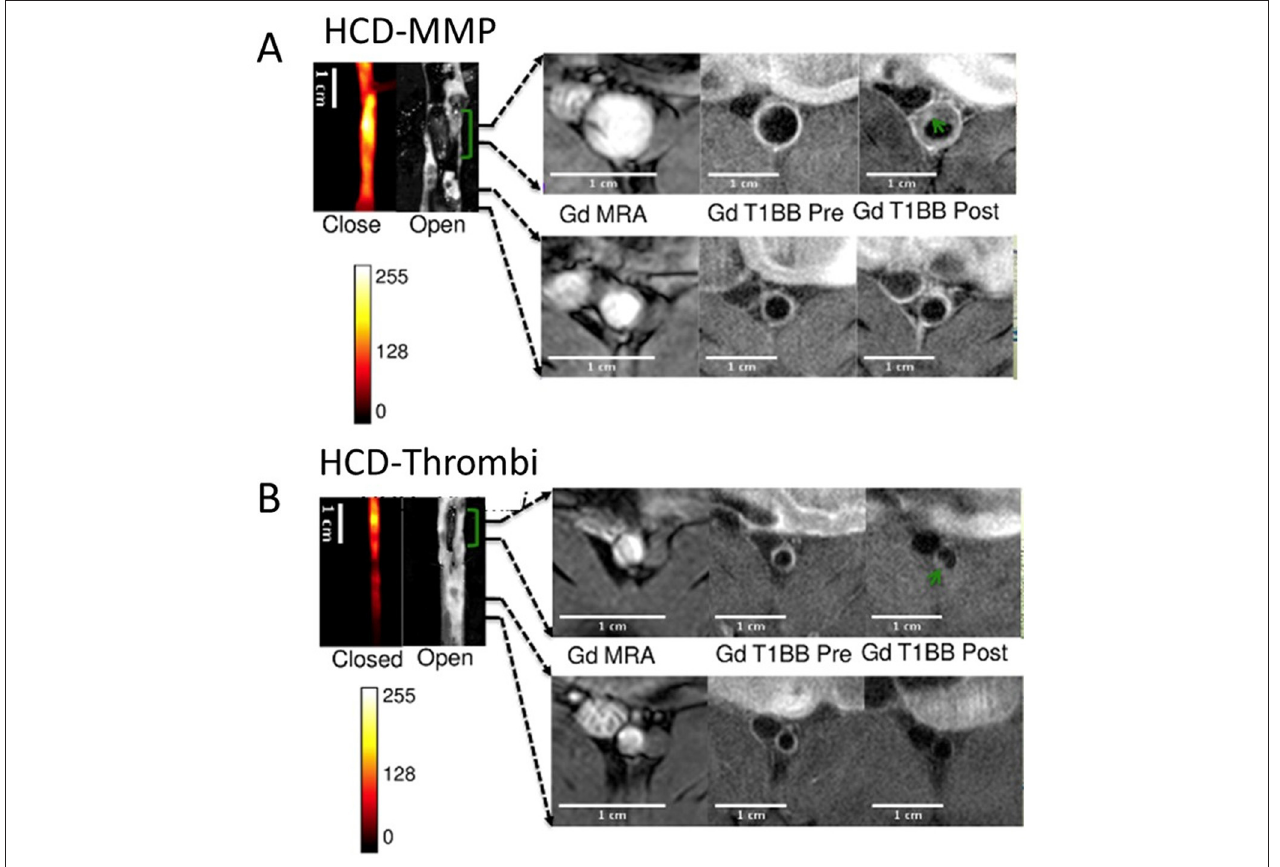
FIGURE 5 | Thrombus imaging. Fluorescence and MRI images of rabbits collected using a (A) HCD + MMP-ACPP probe and (B) HCD + Thrombin-ACPP probe, respectively. The closed view of the fluorescence images shows a sub-section of the abdominal aorta and the corresponding open view reflects images showing the location of thrombi (green brackets). The regions within the two black lines represent examples of non-disrupted and disrupted plaques, respectively, and correspond to the MRI images on the right. All MRI images were obtained after injection of Gd-DTPA according to acquisition protocols. Illustrated are the pre-triggering magnetic resonance angiography (MRA) and the fat suppressed T 1 BB images obtained before and after pharmacological triggering (from left to right). Thrombi are marked by green arrows in post-triggering Gd-T 1 BB (T 1 black blood) images [adopted from ( 75)]. HCD, high-cholesterol diet; MMPs, matrix metalloproteinases; ACPP, activatable cell-penetrating peptides; Gd, DTPA, gadolinium